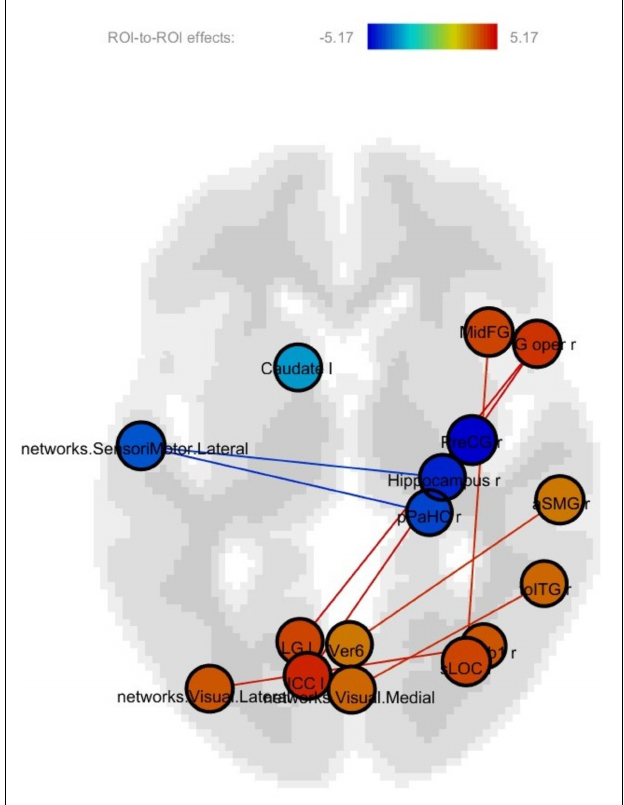
FIGURE 3 | Post-training > pretraining connectivity.